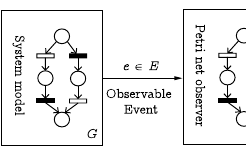
Figure 3. Observer of the RG in Fig. 2.